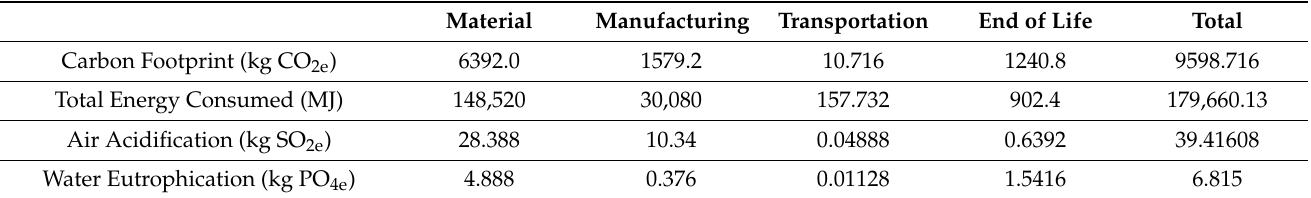
Table 3. Presentation of emissions obtained via LCA analysis for the analysed object for EPS with a thickness of 10